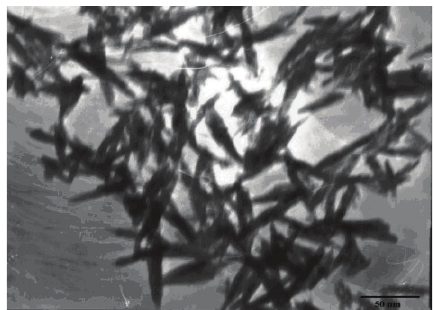
Figure 1: TEM image of an in-house synthesized